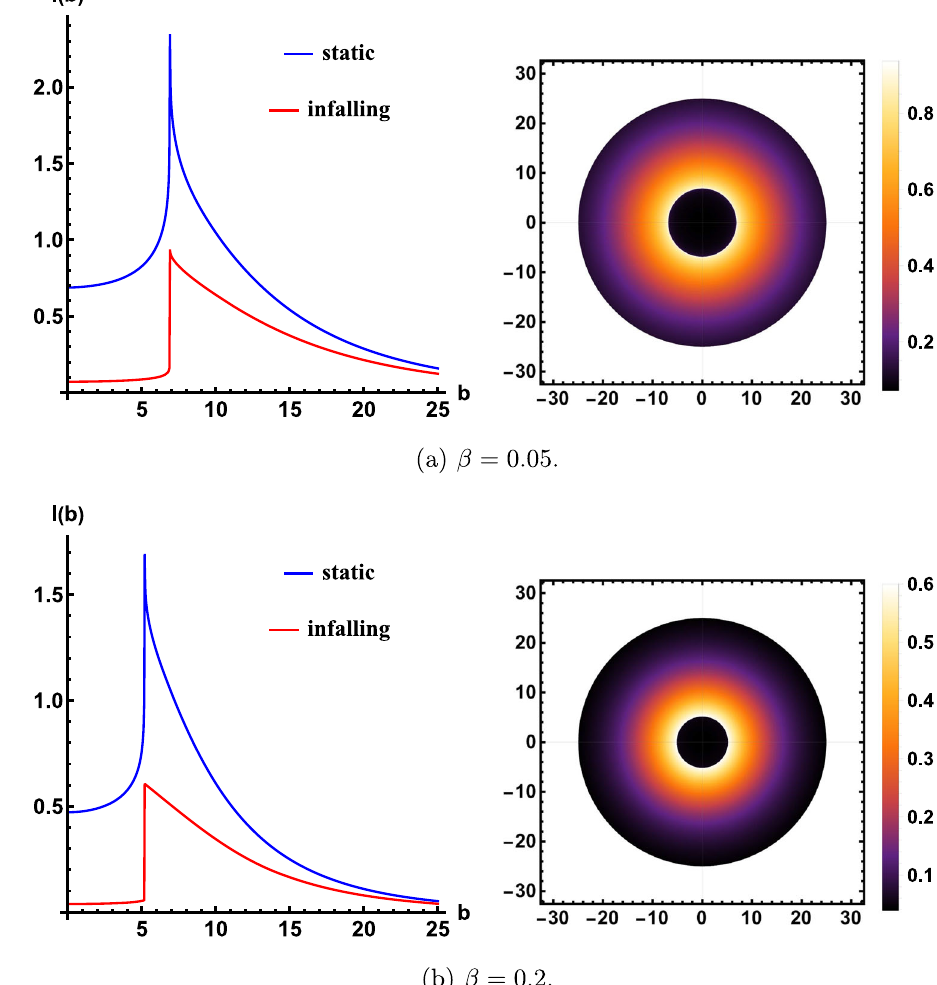
Fig. 8 The specific intensity I with respect to different impact parameters b in the left panels with static and infalling accretions for different β with fixed P = 0 . 6 and M = 1. And the shadows with these parameters for infalling accretions are shown in the right